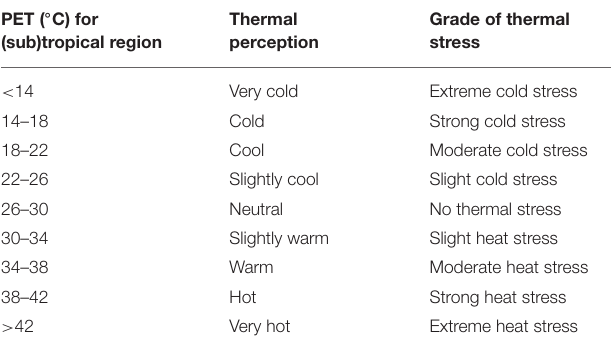
TABLE 2 | Thermal sensation classification for (sub)tropical regions [source: according to Matzarakis et al. (2010), Morakinyo et al. (2017)]. PET ( ◦ C) for (sub)tropical